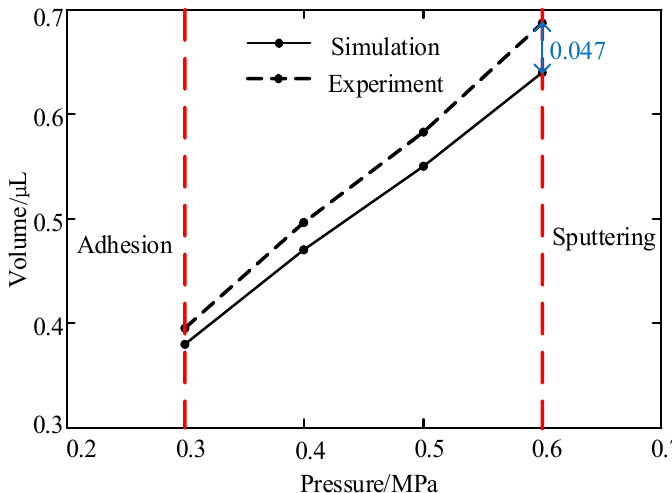
Figure 7. The influence of pressure on the volume of the droplet. Conditions: The nozzle diameter is 0.2 mm, the needle stroke is 0.3 mm, the frequency is 20 Hz, and the viscosity is 0.4 Pa·s.